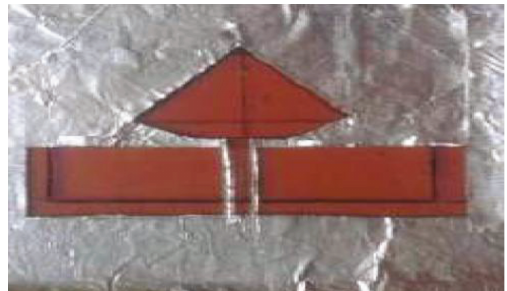
Figure 16: A low-pro fi le, compact-sized, planar fl exible antenna designed on a natural rubber substrate